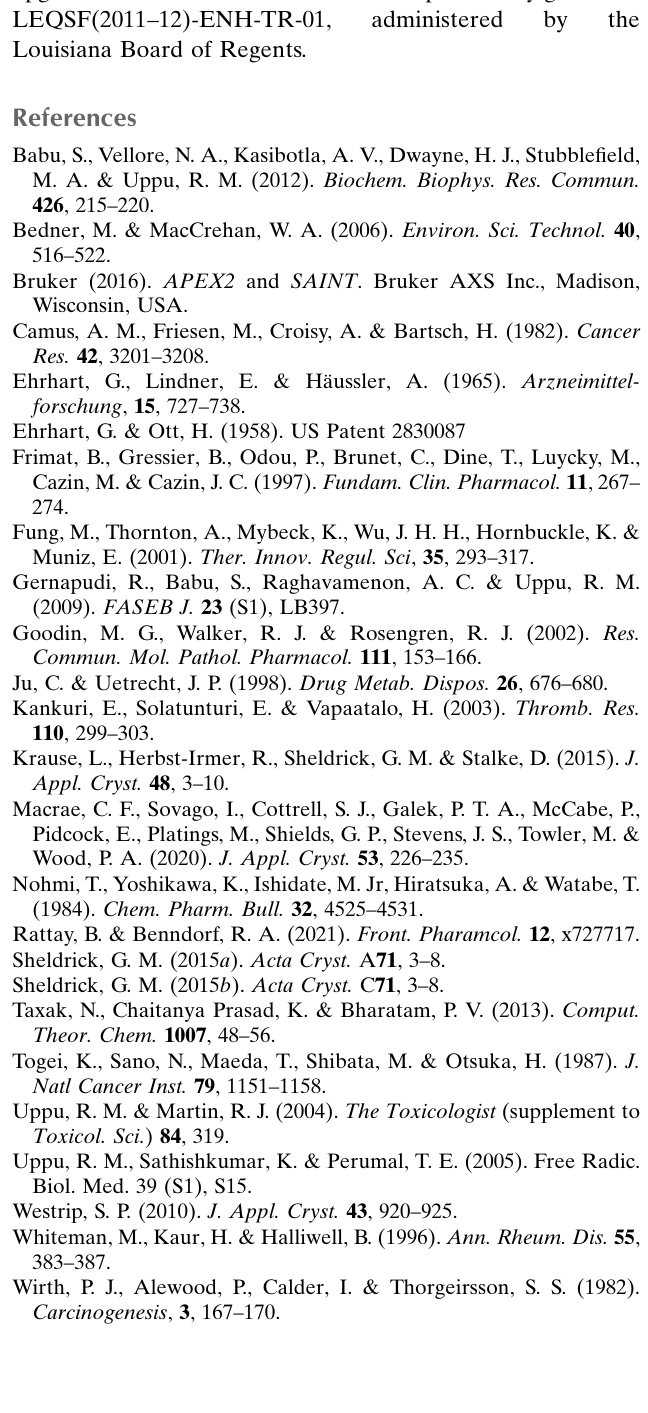
Crystal data Chemical